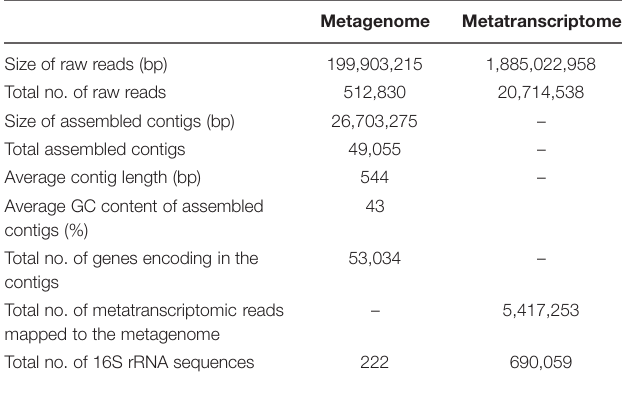
TABLE 1 | Summary of the metagenome and